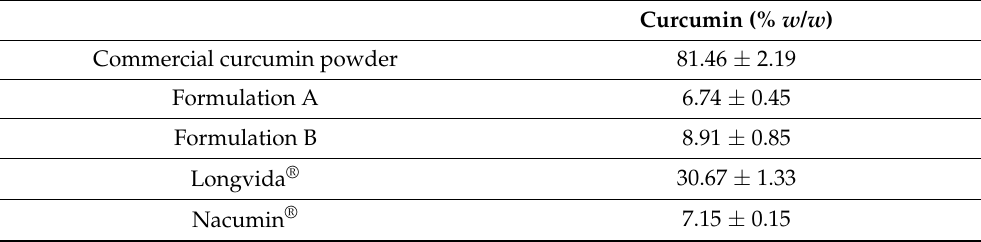
Table 4. The concentration of each test sample needed to prepare a donor suspension containing 0.1